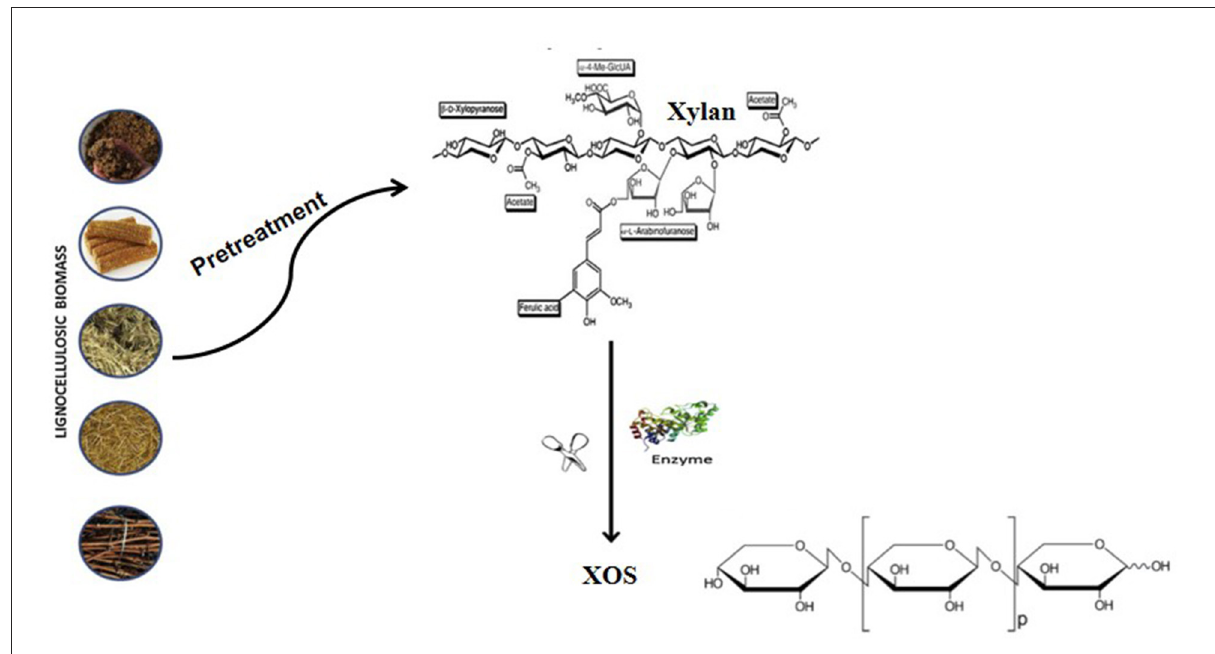
FIGURE3 Schematic representation of XOS manufacture by enzymatic